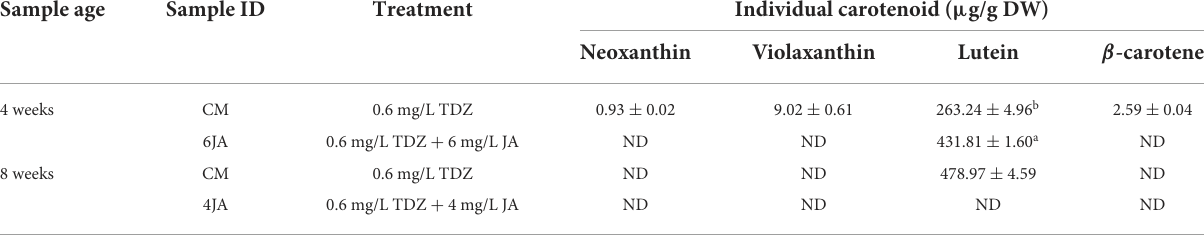
TABLE 3 Distribution and amount of individual carotenoids present in 4 and 8-week-old green callus of A. indica .